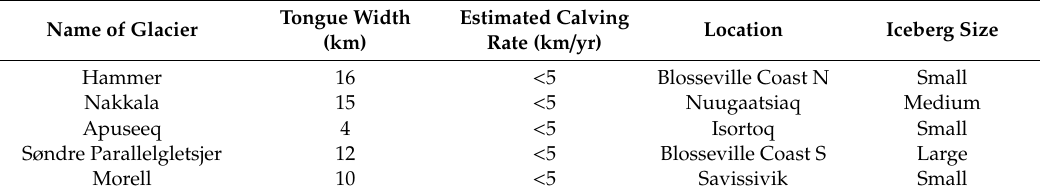
Table 4. Glacier geophysical parameters. Note that the tongue widths, calving rates and iceberg sizes are estimates. Glacier names are taken from a database of known Greenlandic